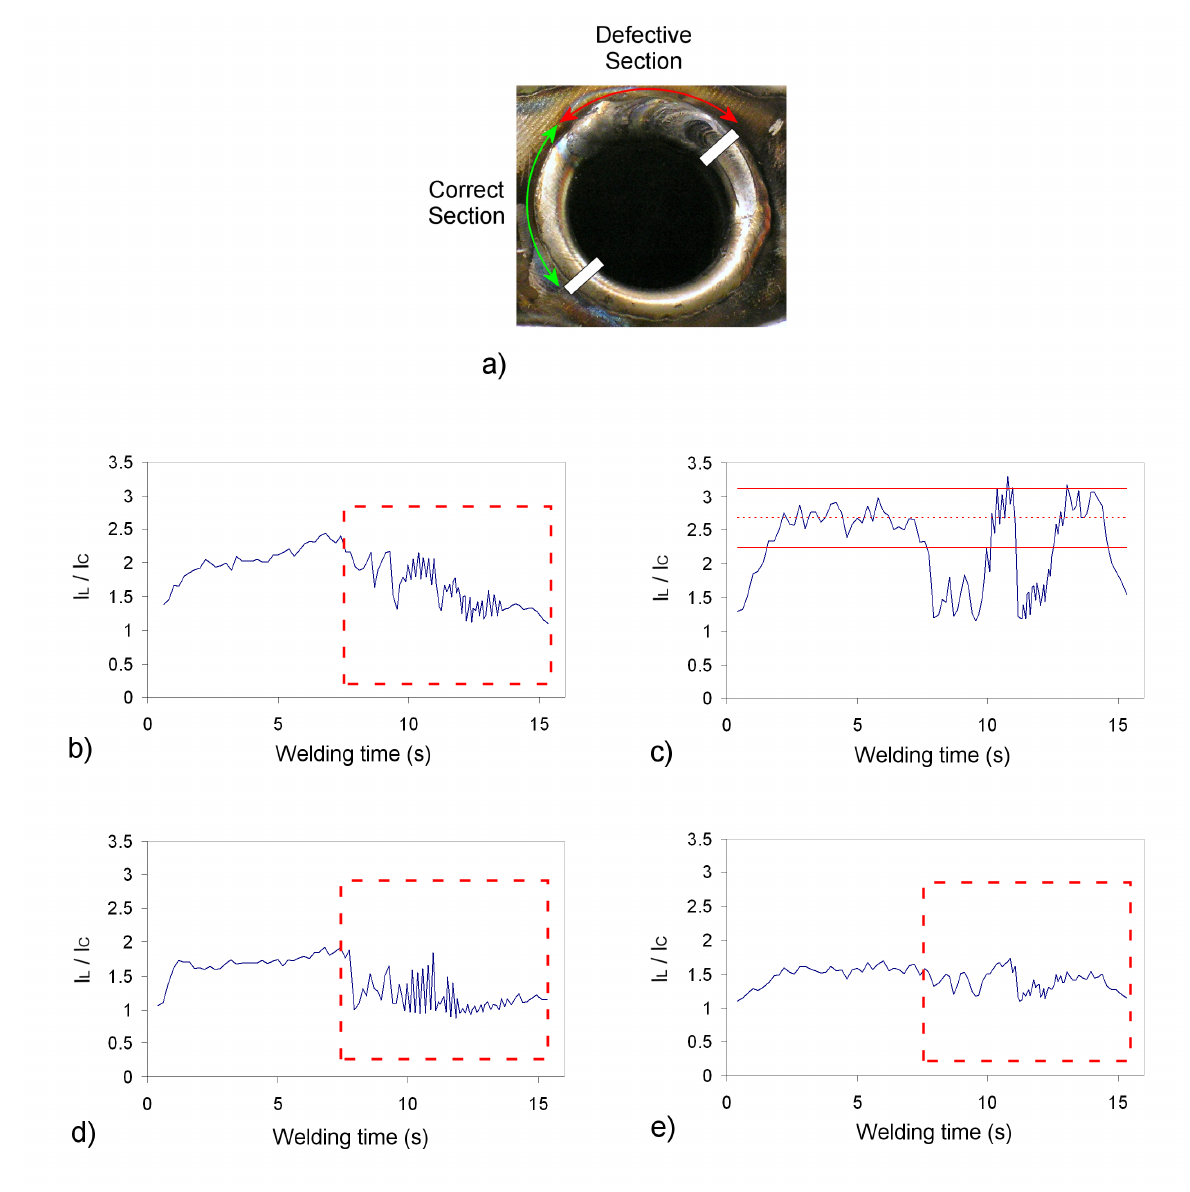
Figure 7. Field test tube with defective section: a) welded tube; b) profile for spectral band 404.14 nm; c) profile for spectral band 422.84 nm; d) profile for spectral band 480.52 nm; e) profile for spectral band 423.64